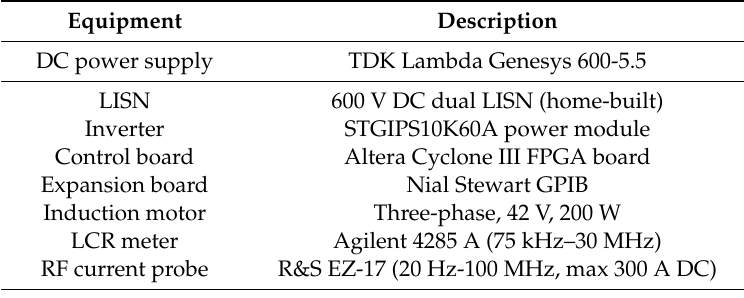
Table 1. Main features of the equipment used in the test setup.